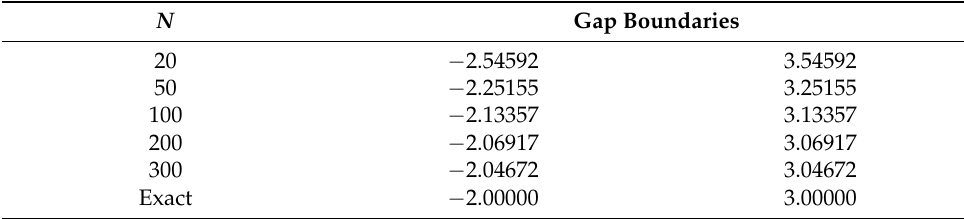
Figure A14. The zeros of P N ( E ) in units of λ 2 for N = 200. We took α = 3, β = 2 and γ = 1. The energy bands extend to infinity and the gap is located in the interval − 2 λ 2 < E < + 3 λ 2 . The system has no bound states. Table A4. The left and right boundaries energy gap in units of λ 2 for different values of N . We took ( 1 ± | 2 α − 1 | ) α = 3, β = 2 and γ = 1. The exact values are λ 2 2